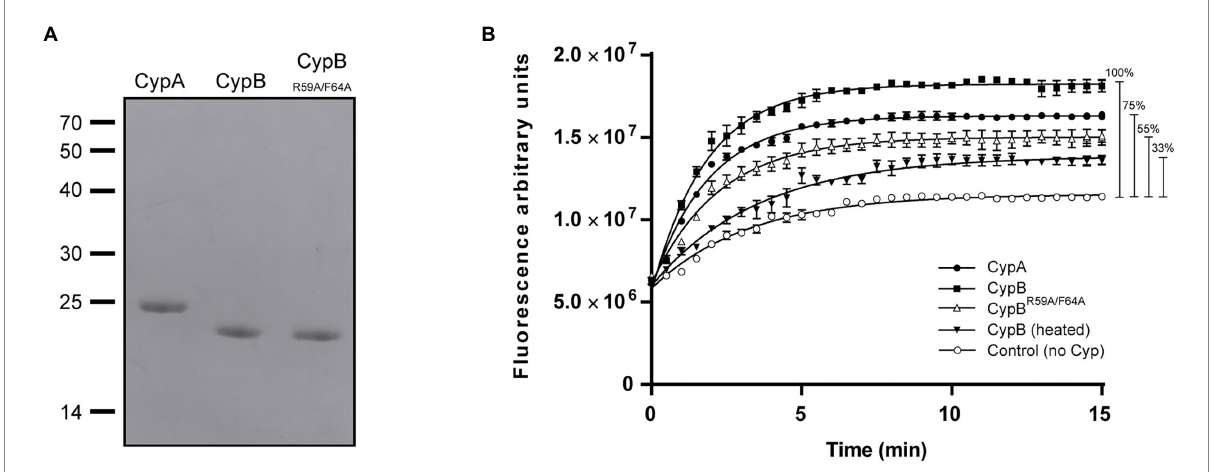
FIGURE 3 PPIase activity determination of recombinant CypA, CypB, and CypB R59A/F64A proteins. (A) SDS-PAGE of purified recombinant cyclophilins stained with Coomassie blue. (B) GFP PPIase activity assay with 2 μ M of CypA, CypB, and with the point mutant in the active site CypB R59A/F64A . The figure shows the mean and standard deviation of the triplicate experiment and is representative of three independent experiments. Two-way ANOVA and Tukey’s multiple comparison test (within each row, compare columns) were used to analyze the statistical significance of the results, **** p <